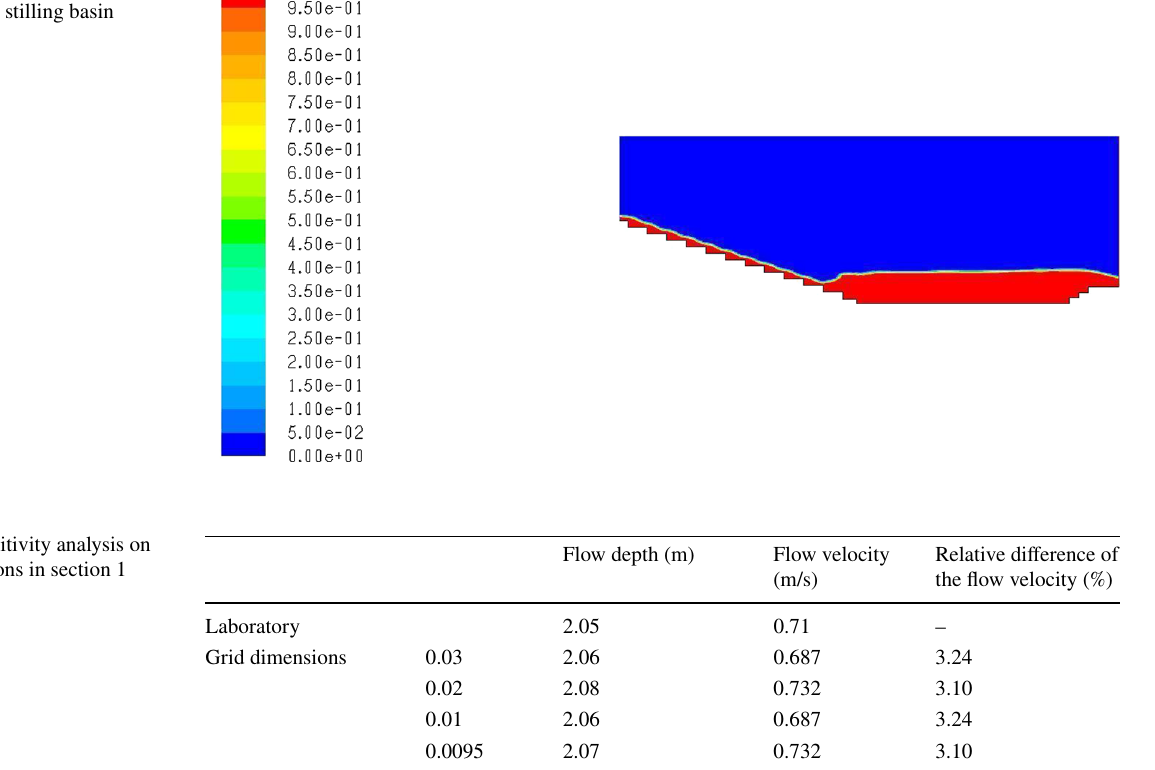
Fig. 5 The flow profile on the chute and the stilling basin